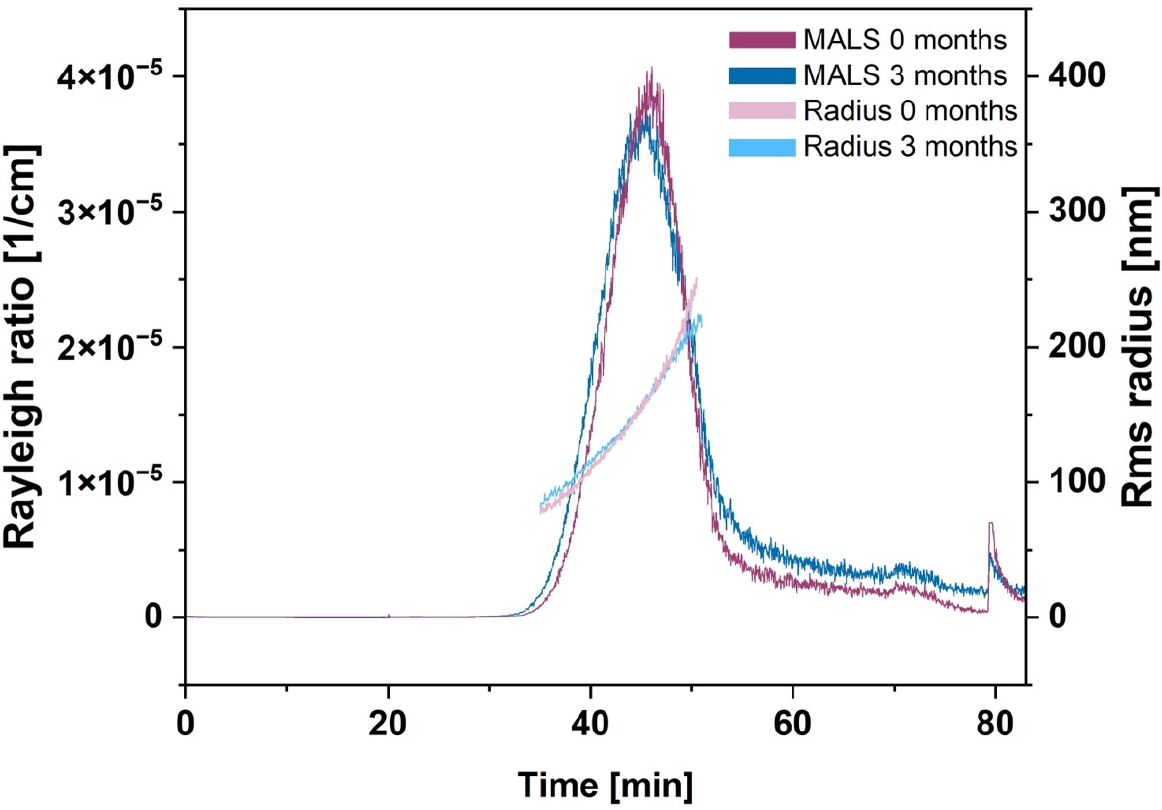
Figure 1. AF4 elugram of albumin-stabilized mitotane (BSA-MT) with MALS signal (90° angle) and corresponding rms radius. Particles were analyzed subsequently after preparation (0 months, purple) and 3 months of storage at 20–24 °C (blue).